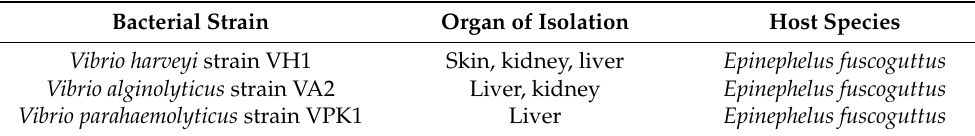
Table 1. Bacterial strains genotype used in this study. Bacterial Strain Organ of Isolation Host Species Vibrio harveyi strain VH1 Skin, kidney, liver Epinephelus fuscoguttus Vibrio alginolyticus strain VA2 Liver, kidney Epinephelus fuscoguttus Vibrio parahaemolyticus strain VPK1 Liver Epinephelus